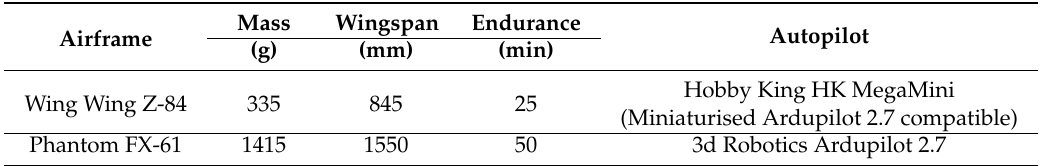
Table 1. Test aircraft